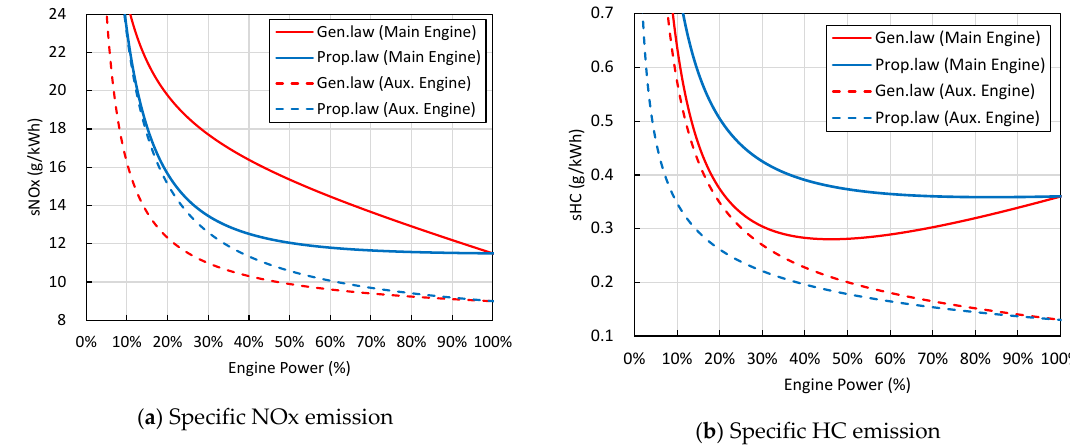
Figure A4. Specific NOx and HC emissions of main engine and auxiliary engines.